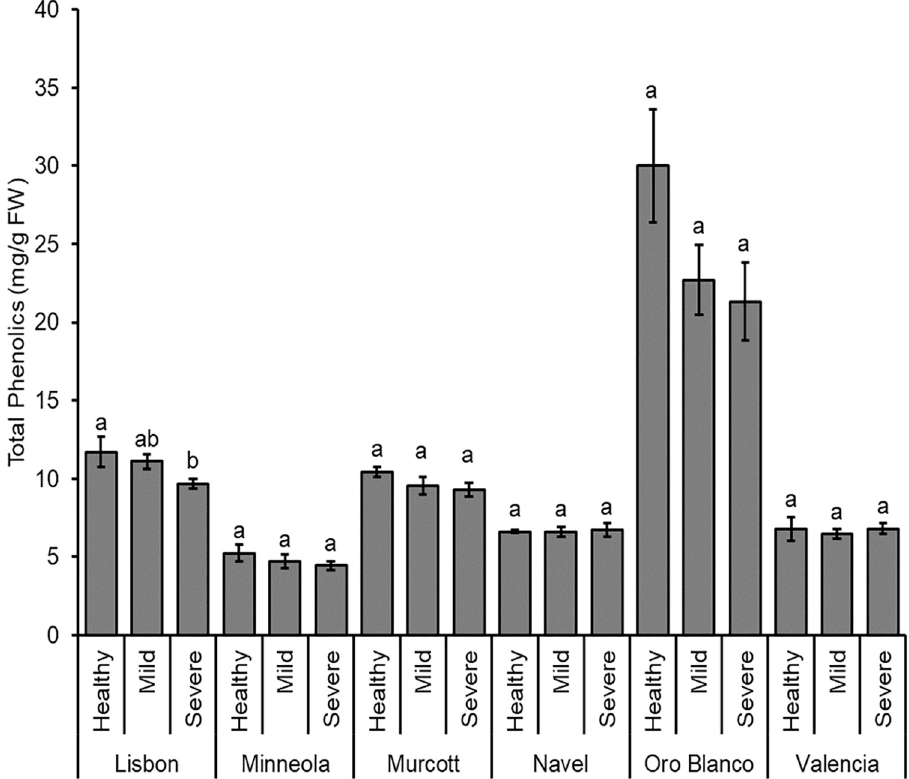
Fig 4. Summed total of all phenolic compounds. Mean of total phenolic compound levels ( ± SE) for each citrus cultivar that was health, CTV-mild strain infected, or CTV-severe strain infected. Different letters represent significantly different means by Tukey HSD tests for each citrus species